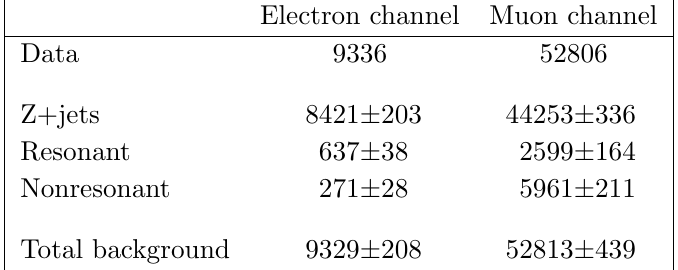
Table 2 . Event yields for di(cid:11)erent background contributions and those observed in data in the electron and muon